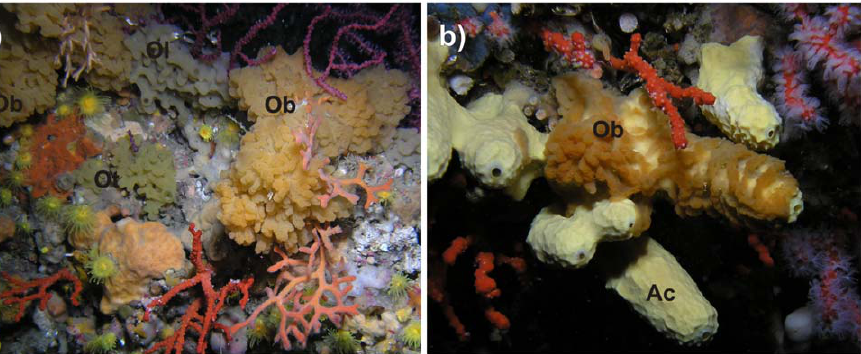
Figure 1. Oscarellabalbaloiinsitu. a) Well developed Oscarella balibaloi (Ob) specimen in the vicinity of two common Oscarella species: Oscarella lobularis (Ol) and Oscarella tuberculata (Ot). b) Oscarella balibaloi (Ob) growing on demosponge Aplysina cavernicola (Ac).